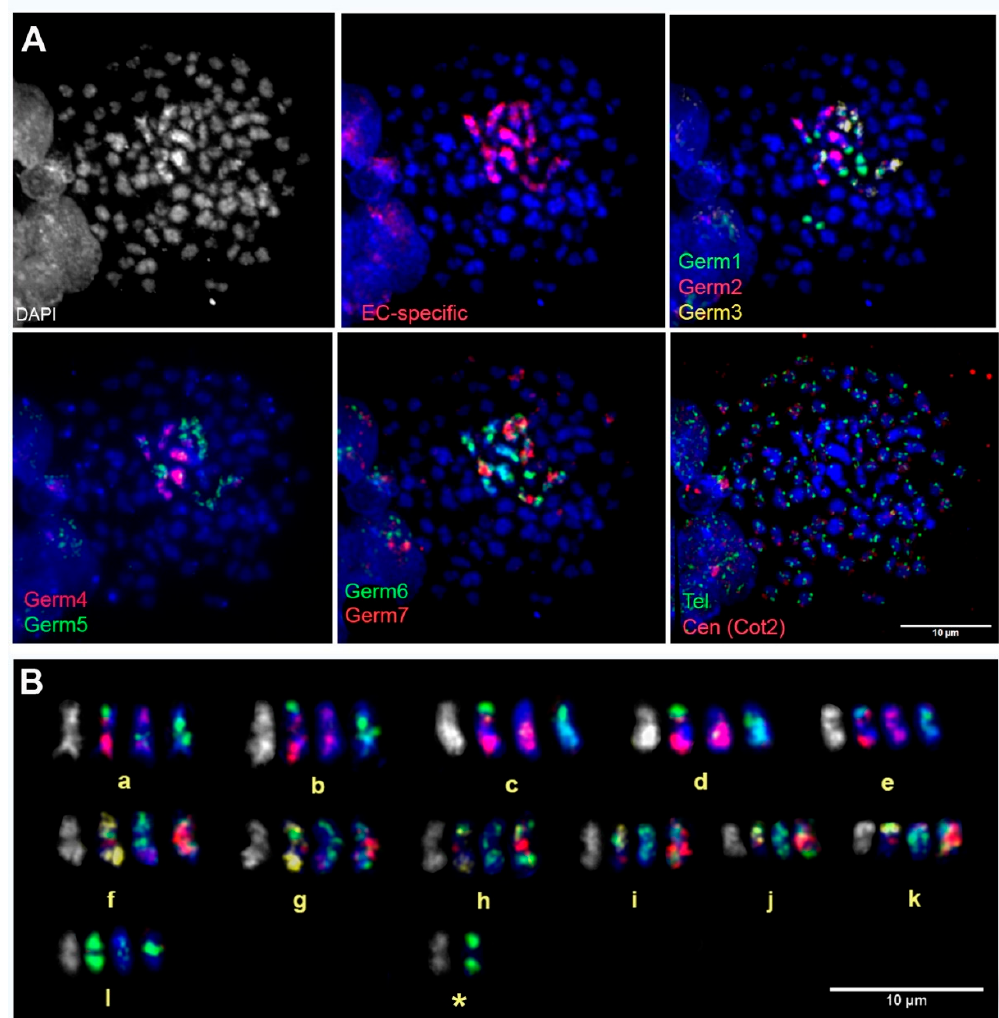
Figure 3. Chromosomal localization of the germline-restricted repeats. ( A ) FISH of Germ 1–7, repeats and telomeric / centromeric (liver C 0 t2) probes on spermatid spreads, with DAPI counterstaining (grey or blue). ( B ) A karyogram of germline-restricted chromosomes (including a somatically-retained bivalent that cross-hybridizes with Germ1 : labeled with an asterisk). This bivalent presumably encodes somatic ribosomal RNAs, which share sequence homology with Germ 1 [19]. Each chromosome in the karyogram ( B ) is shown in four states: 1: grayscale DAPI counterstain; 2: hybridized with Germ 1 (FITC, green), Germ 2 (Cy3, red), and Germ 3 (Cy5, pseudocolored in yellow); 3: hybridized with Germ 4 (FITC, green) and Germ 5 (Cy3, red); 4: hybridized with Germ 6 (FITC, green) and Germ 7 (Cy3, red).